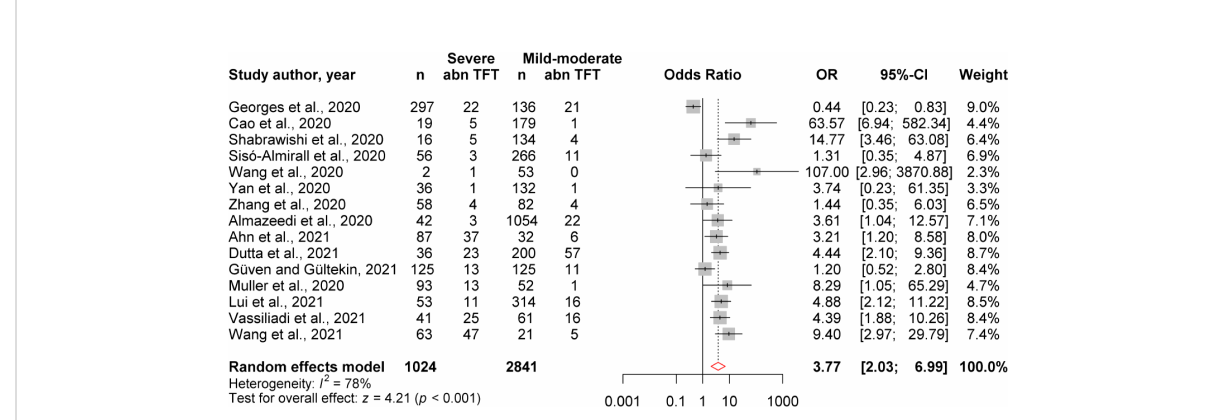
FIGURE 4 Evaluation of OR of abnormal TFT for COVID-19 severity. Experimental: patients faced severe to critical form of COVID-19, Control: patients faced mild to moderate form of COVID-19, Events: patients with abnormal TFT.